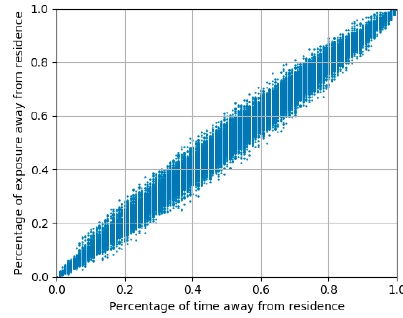
Figure 12. Residential locations with high exposure individuals.